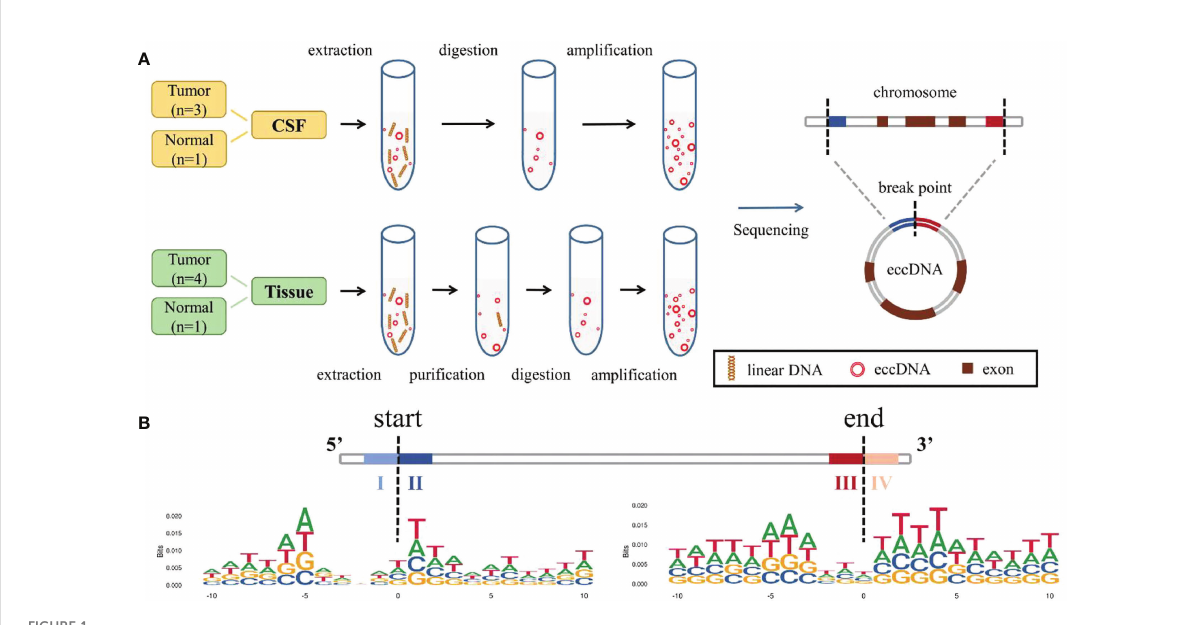
FIGURE 1 Identi fi cation and mapping process of eccDNAs in samples. (A) Two different methods were used to extract, enrich, and amplify eccDNAs from MB tissue samples and CSF samples, respectively, then compared to the reference genome. (B) Trinucleotide motif sequences fl anking the start and end positions of eccDNA in normal CSF were labeled as I, II, III, and IV. eccDNAs, extrachromosomal circular DNAs; MB, medulloblastoma; CSF, cerebrospinal fl